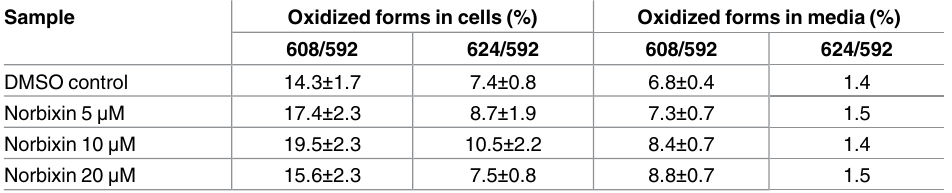
Table 1. Relative abundance of mono- and di-oxidized forms of A2E in cells and media: effect of norbixin.